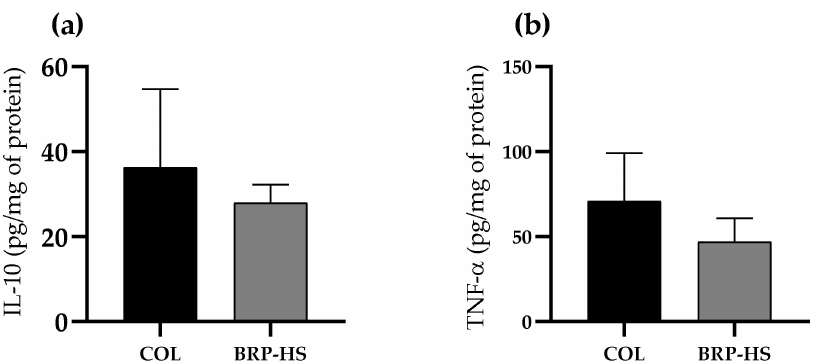
Figure 13. IL-10 ( a ) and TNF- α ( b ) quantification results in pg/mg of protein in groups treated over 14 days with Collagenase 1.2 UI (COL) or BRP-HS. No significance was found according to an unpaired t test ( n = 6).